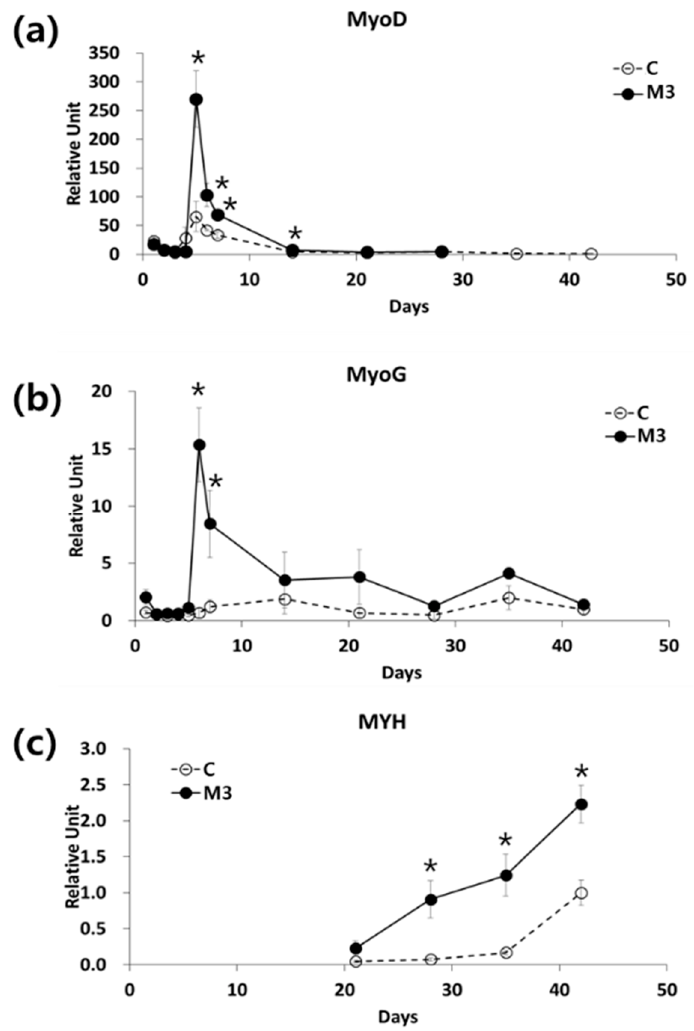
Figure 2. Effect of a combination of IL-6 and C2C12 CM on myogenic differentiation. mRNA expression of ( a ) MyoD, ( b ) myogenin (MyoG), and ( c ) myosin heavy chain (MYH) during myogenic differentiation, mRNA expression was analyzed by qRT-PCR. n = 3 independent experiments, each assay was performed in duplicate All values are expressed relative to the gene expression observed at 6 weeks using protocol C. * p < 0.05 vs. protocol C.